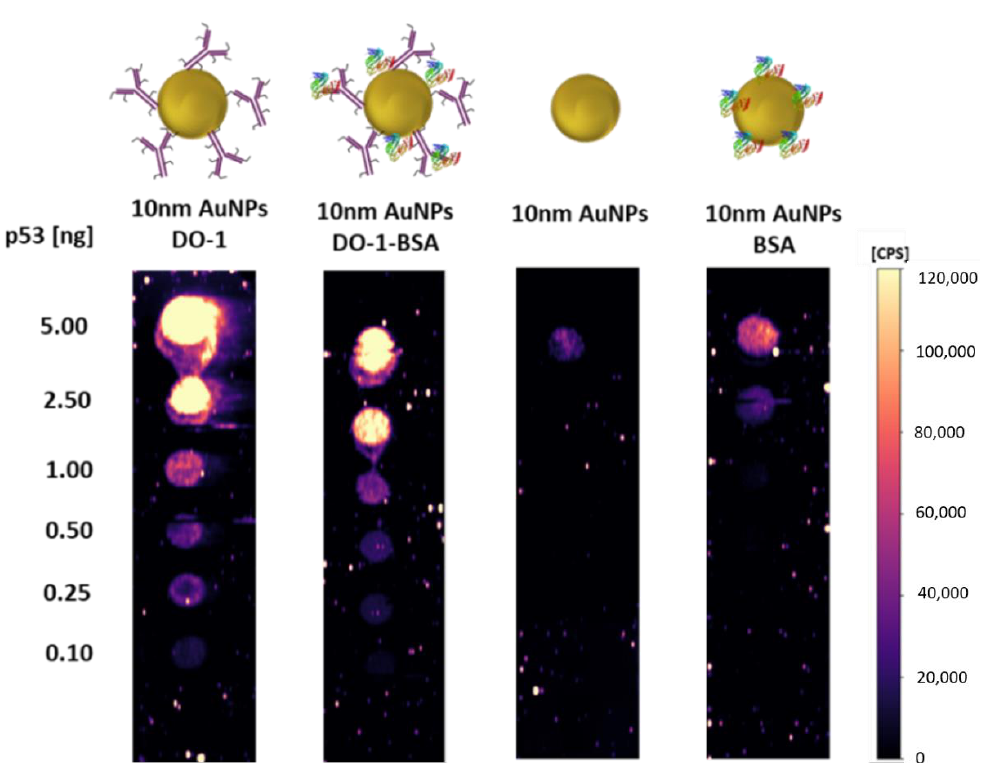
Figure 7. Dot-blot analyses of p53 using AuNPs-DO-1, AuNPs-DO-1-BSA, AuNPs, and AuNPs-BSA.